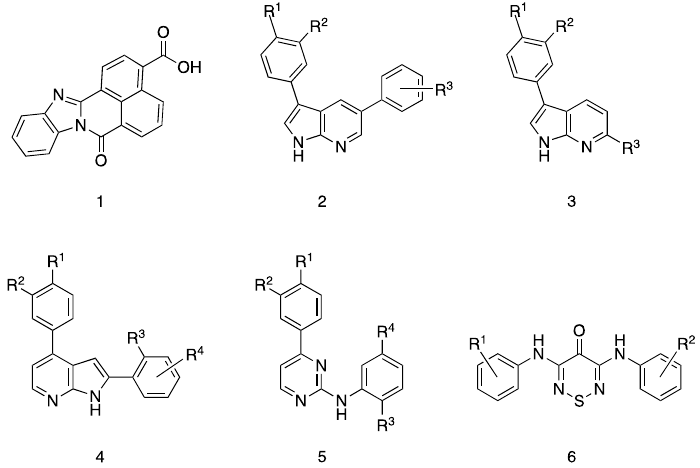
Figure 4. The most cited CAMKK2 inhibitor STO-609 ( 1 ). The scaffolds of CAMKK2 inhibitors ( 2 – 6 ) with structure activity studies described in the literature